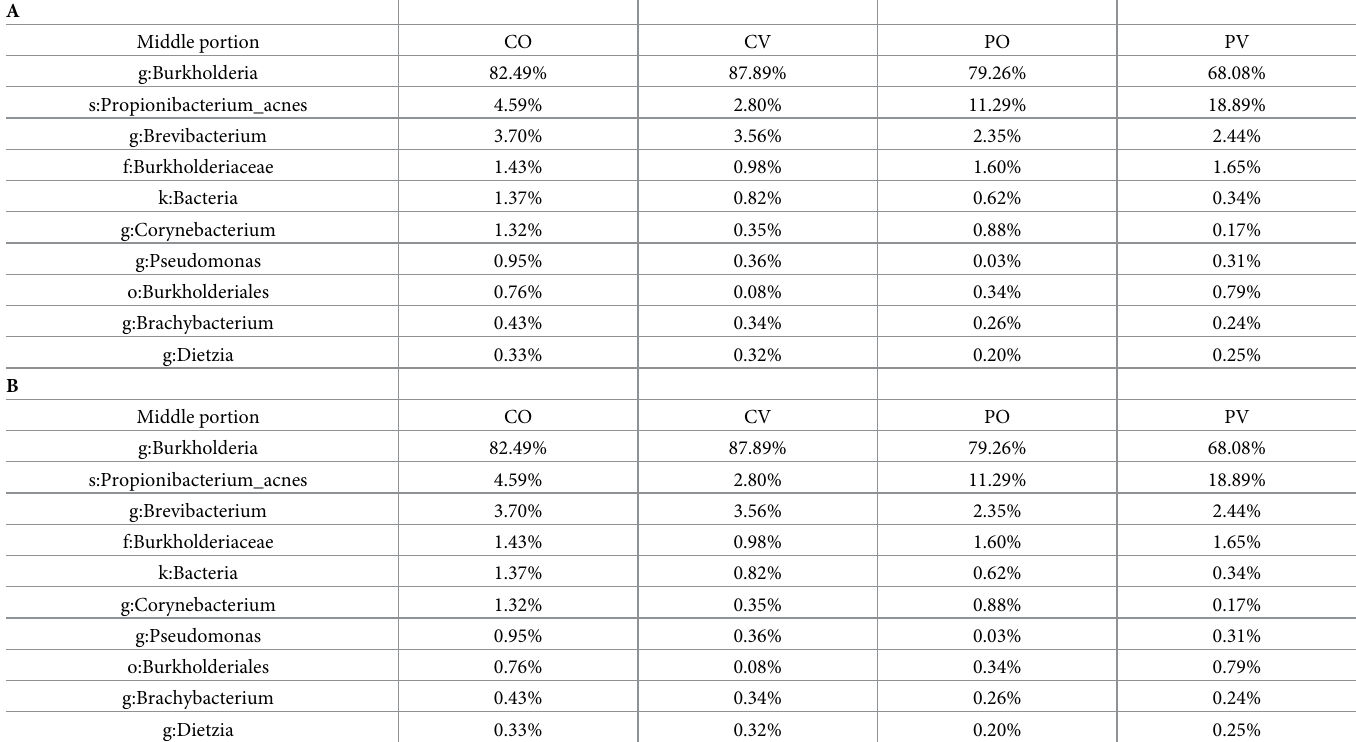
Table 1. Representative bacterial genera abundance in middle and lower sample portions from patients and controls.